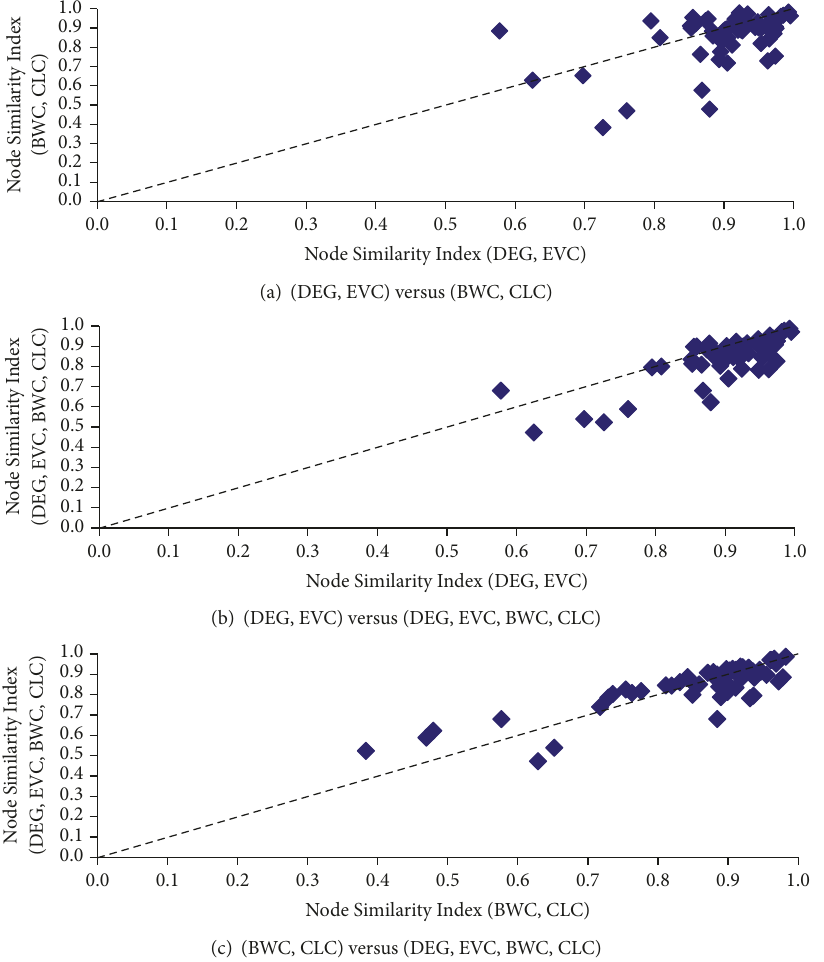
Figure 5: Comparison of the NSI values for the real-world networks based on the coordinate